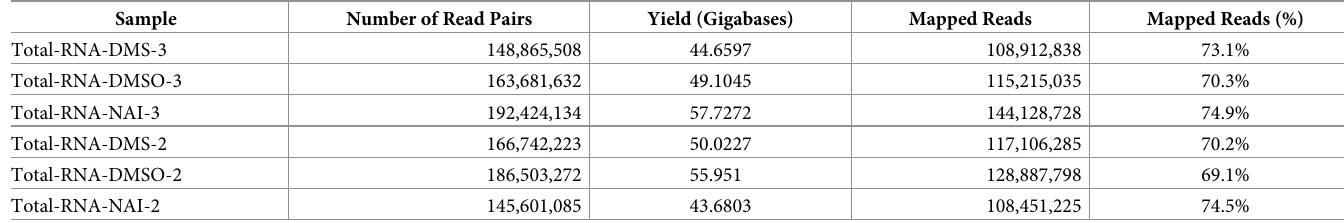
Table 1. Sequencing parameters for each NGS library generated in this